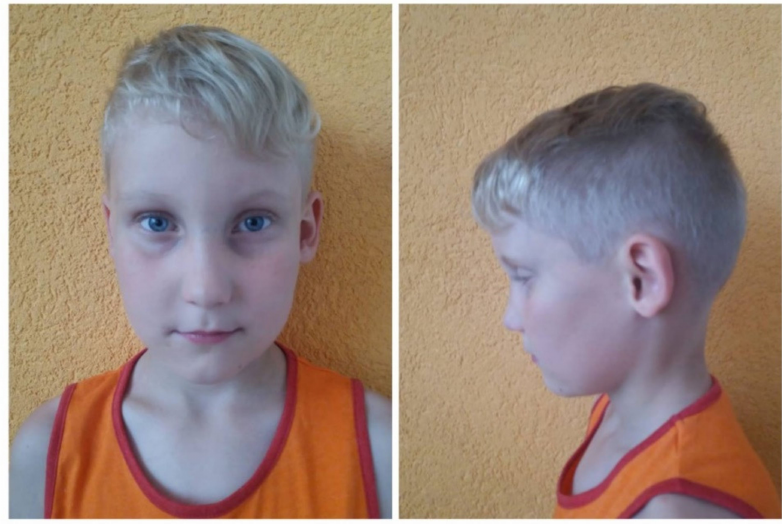
Figure 2. The ALGS1 patient: characteristic triangle-shaped facial appearance with a broad forehead, deeply-set eyes, hypertelorism, low-set ears and long onion-shaped nose (patient no.